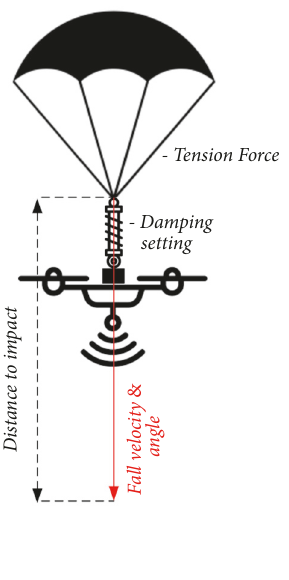
Figure 1: Model of parachute